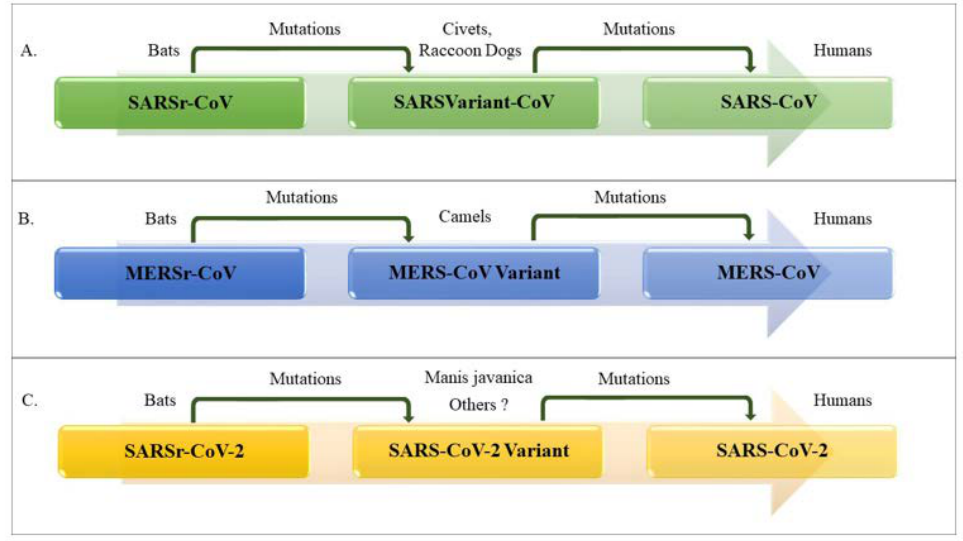
Figure 2. Origin and evolution of ( A ) SARS-CoV, ( B ) MERS-CoV and ( C ) SARS-CoV-2 in the various hosts. Initially all viruses existed in diverse bat species as CoV-related viruses (SARSr-CoV, MERSr-CoV and SARSr-CoV-2); sequential mutations and recombinations allow them to adapt to intermediate hosts and finally humans [15].